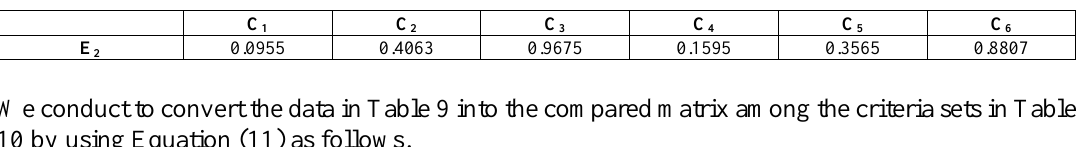
Table 9. The impact evaluation data among the criteria sets of the expert E 2 .